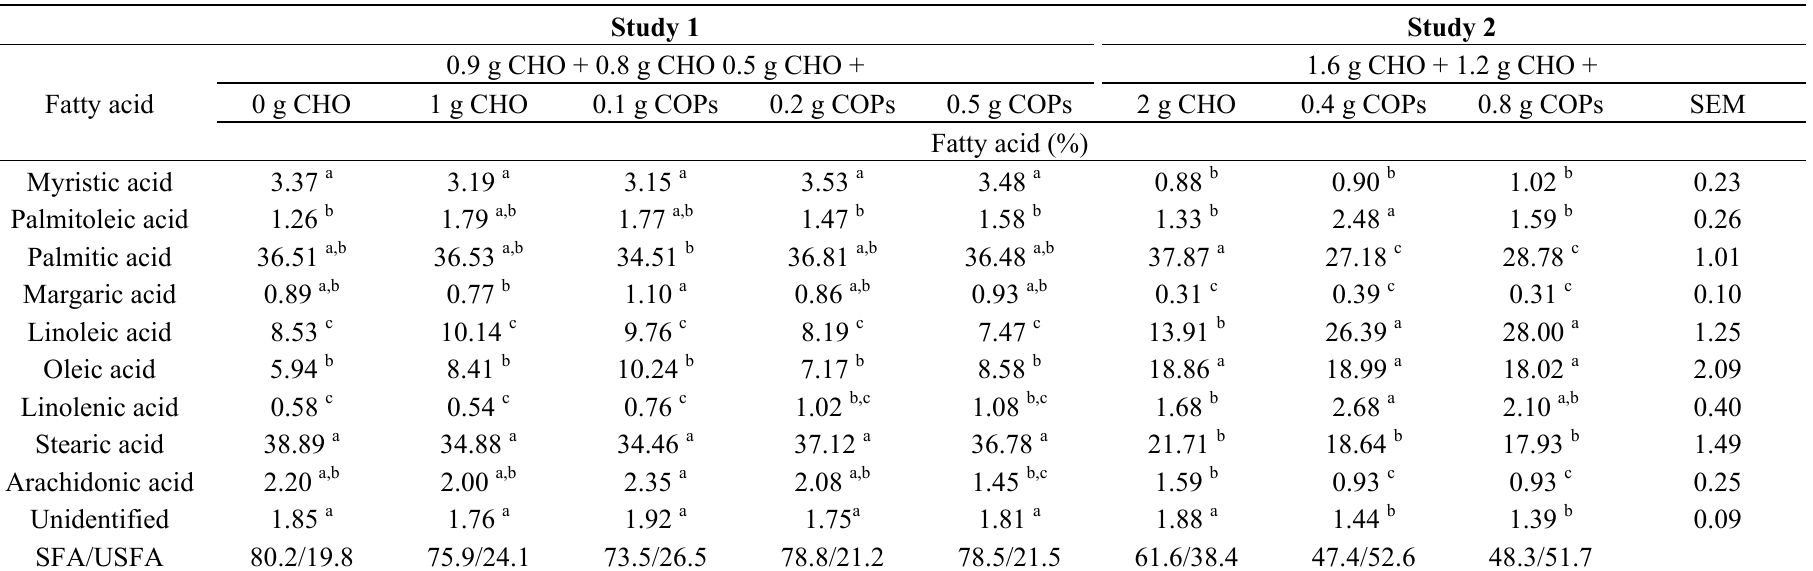
Table 6. Fatty acid composition of erythrocytes